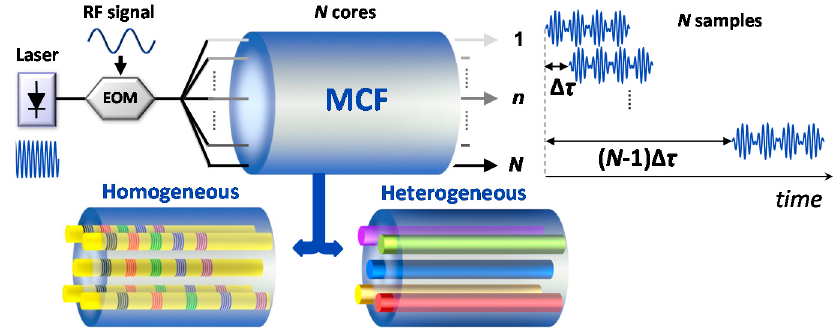
Figure 1. General concept underlying the sampled true time delay line built upon a multicore fiber.